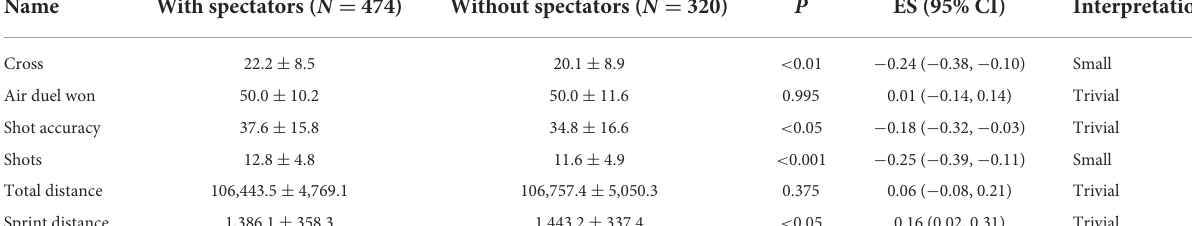
TABLE 2 The difference in technical and physical variables between matches with and without spectators.